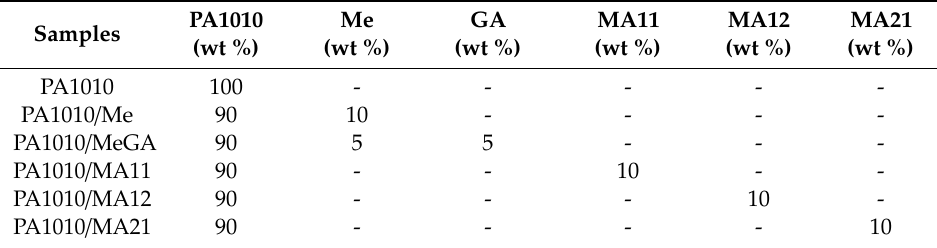
Table 1. PA1010 composites